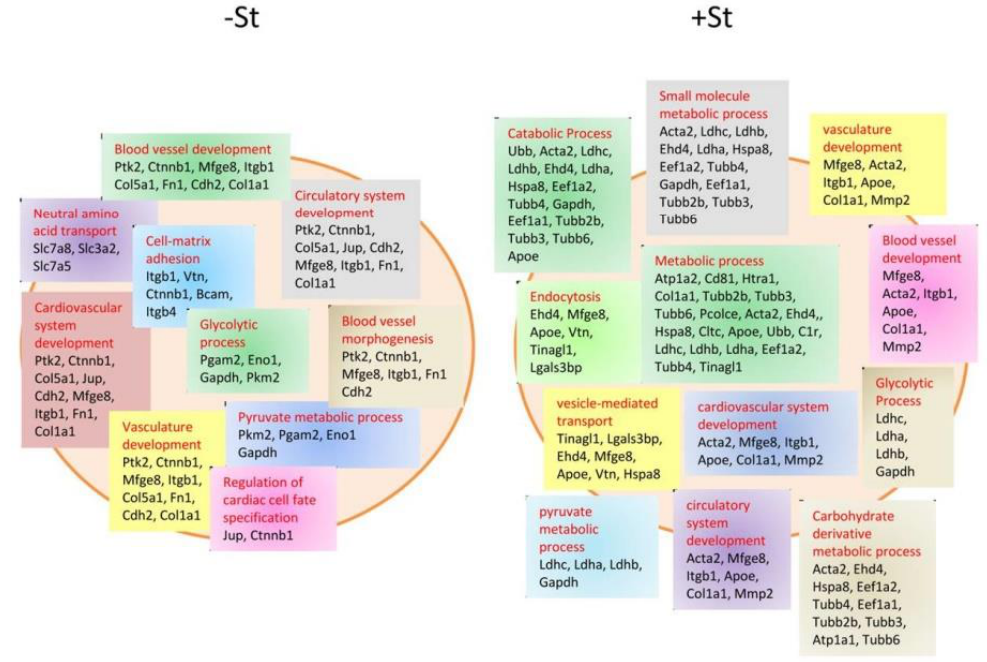
Figure 3. Schematic representation of protein content in EXOs from starved (+St), i.e., glucose-deprived, and non-starved ( − St) CMs. CMs deprived of glucose change the protein pool contained in their EXOs, promoting their loading with proteins related to metabolic and catabolic processes, as well as blood vessel and cardiovascular development [24].